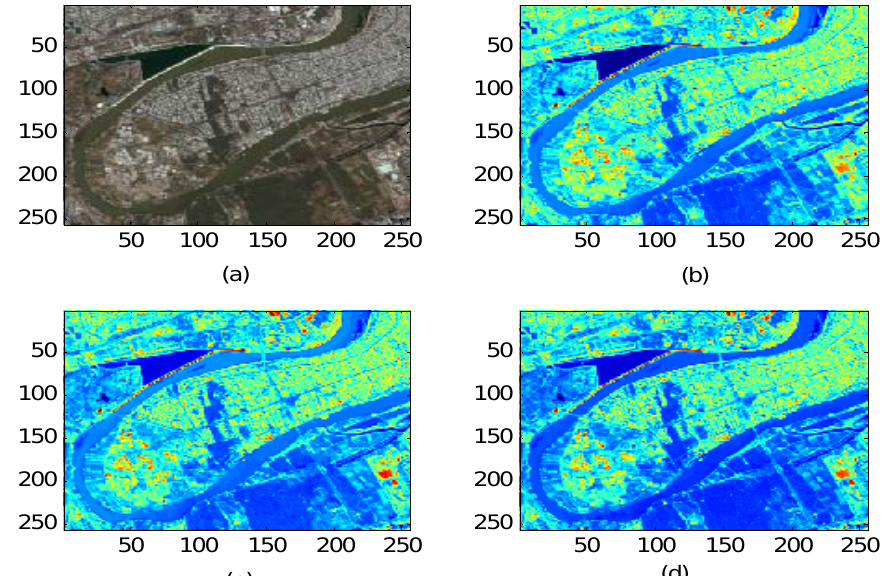
Fig. 1: (a)24-bit RGB color Satellite image (b)Red- band, (c)Green-band, and (d)Blue –